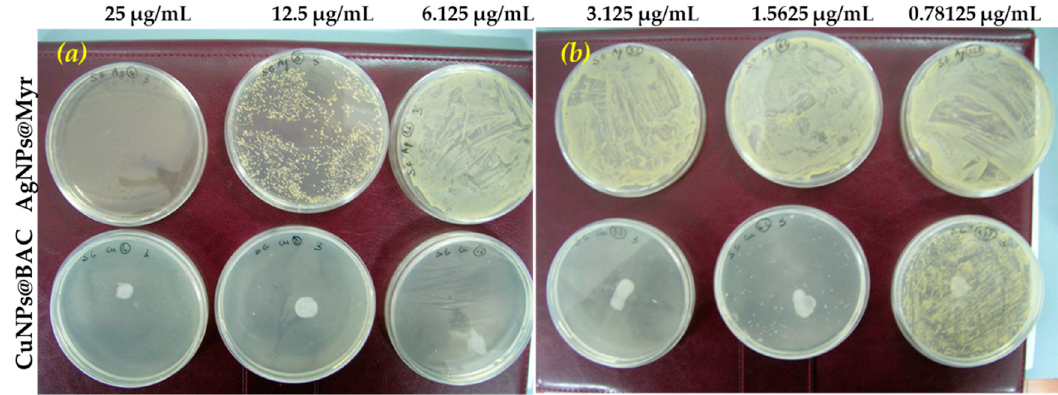
Figure 3. Petri plates for microorganism #3 incubated with AgNPs (upper line in ( a ) and ( b )) and CuNPs samples (bottom line in ( a ) and ( b )). (Please note that the big white circle in each plate supplemented with CuNPs is not a bacterial colony, but is due to the plastic of Petri plate tarnished by the contact with the nanomaterial ).